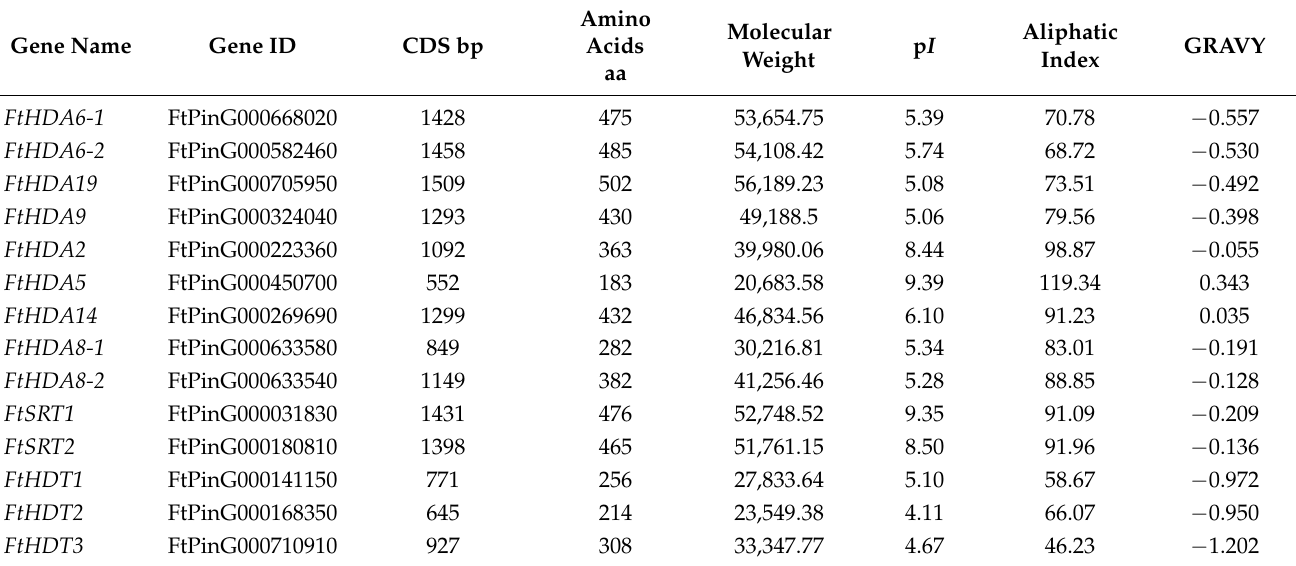
Table 1. Basic information of HDACs gene family in Fagopyrum tataricum